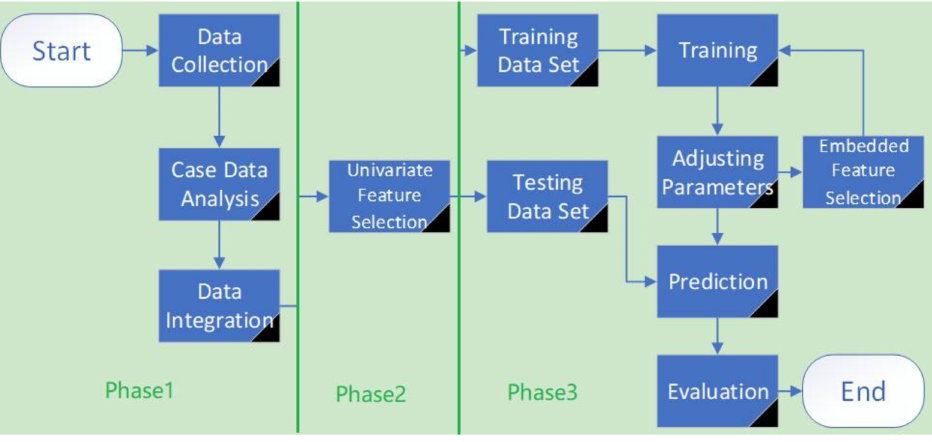
Figure 1. Approach